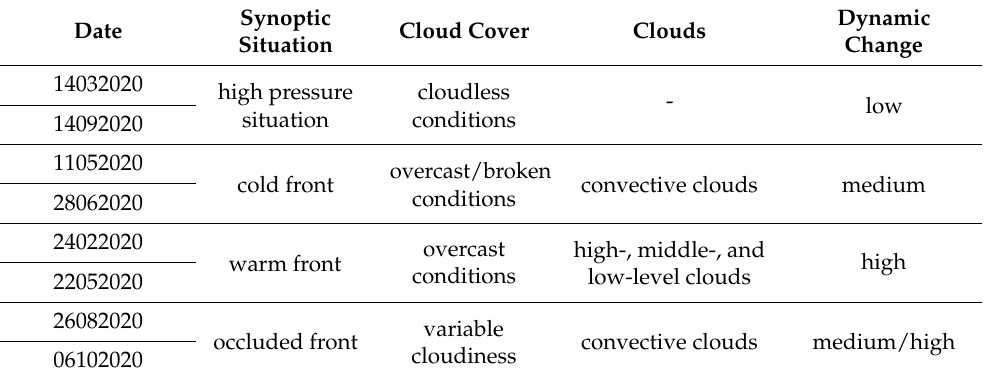
Table 1. Summary of analyzed